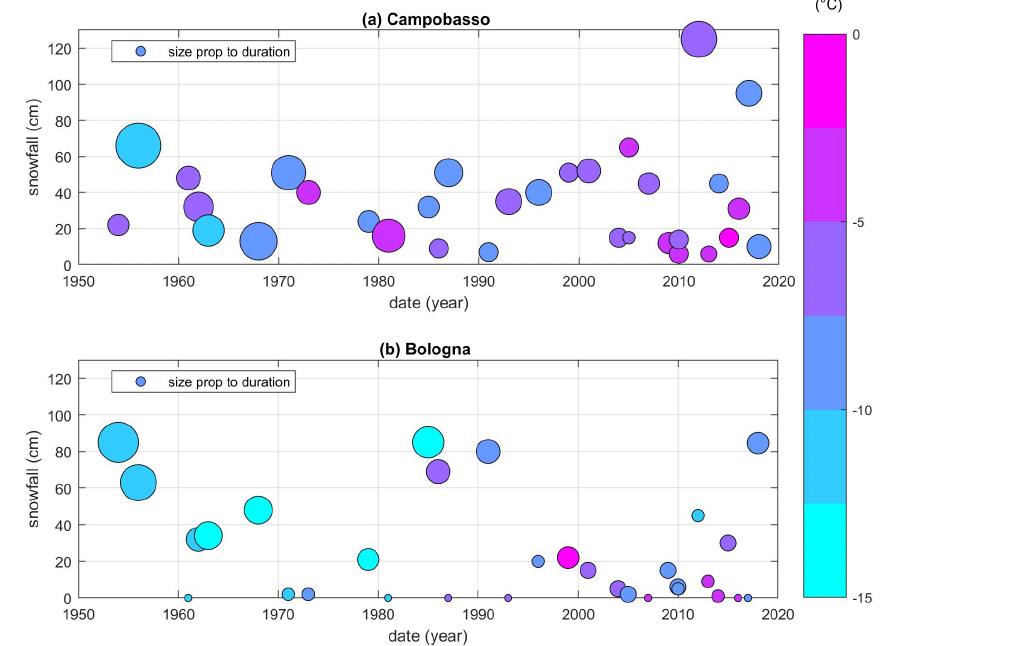
Figure 1. Cold spells from documentary sources. Data recorded in (a) Campobasso (686m altitude); (b) Bologna (54m altitude). Each ball represents one cold-spell event. The diameter is proportional to the number of snowfall days. The y axis shows the snowfall measured during each event. The colour shows the minimum near-surface temperature recorded during the event (see “Sources and dataset”